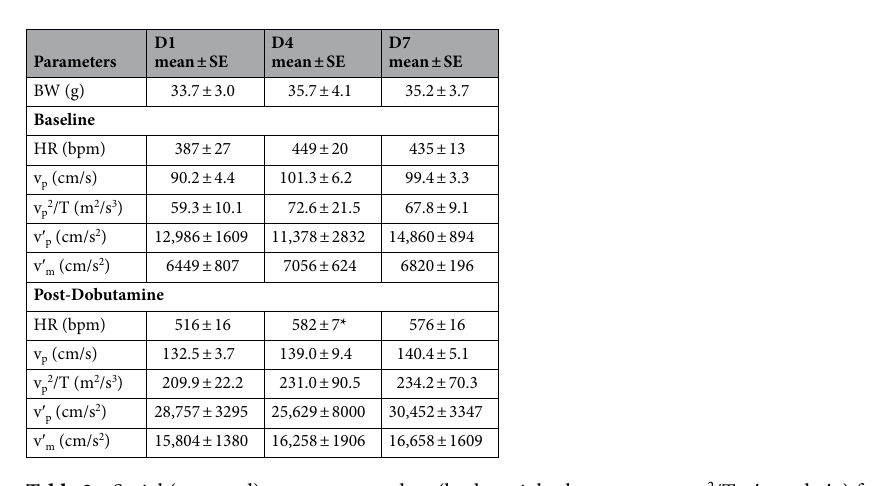
Table 3. Serial (repeated) measurement data (body weight, heart rate, v p , v p 2 /T, v ′ p , and v ′ m ) from group 2 mice. Comparison of baseline data (D1 vs. D4; D1 vs. D7; D4 vs. D7) showed no significant differences. Comparison of post-dobutamine data also showed no significant differences except D1and D4 heart rates (* p <